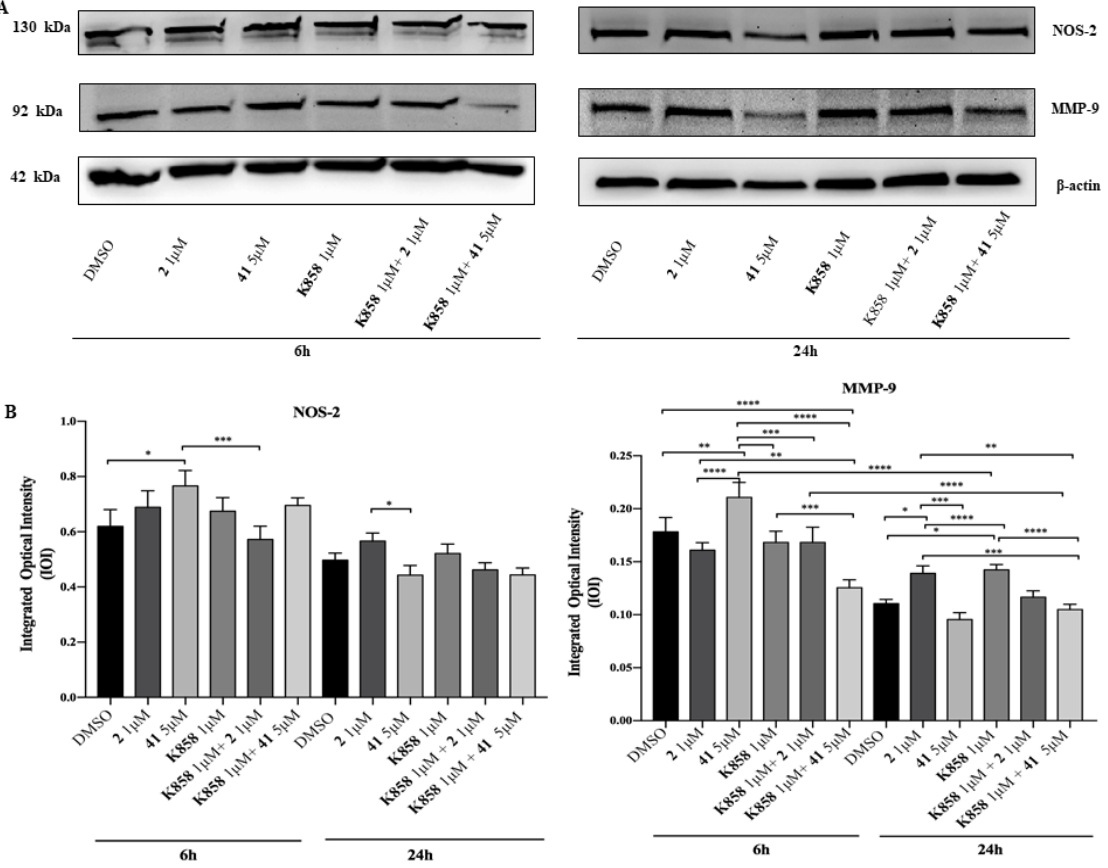
Figure 7. Western blotting analysis of Matrix Metalloproteinase 9 (MMP-9) and Nitric Oxide Synthase (NOS-2) expression in AGS treated with compounds 2, 41, and K858 as single agents and in co-treatment . ( A ) Cells treated with DMSO (0.2%) were loaded as negative control. Each membrane was probed with β -actin antibody to verify loading consistency. Western blot is the most representative of three di ff erent experiments. ( B ) Histograms represent densitometric measurements of proteins bands expressed as integrated optical intensity (IOI) mean of three separate experiments. The error bars show standard deviation ( ± SD). **** p < 0.0001, *** p < 0.0002, ** p < 0.0005, * p <